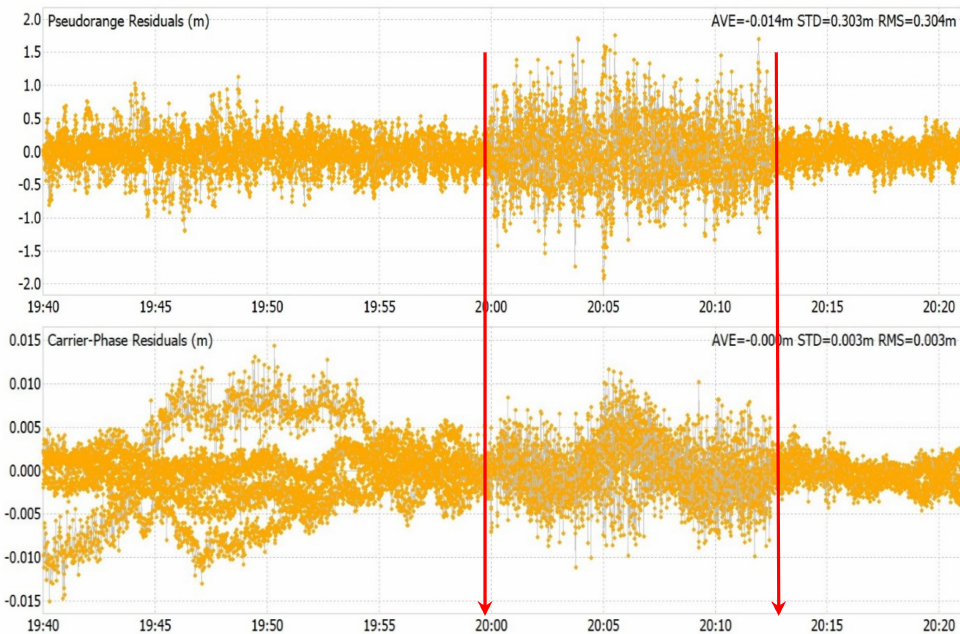
Figure 8. Residuals per satellite in a DGPS (top) and PPK float (bottom) solution for Case 3, baseline 1 (4.1 km) using only L1 data from select satellites (G07, G10, G16, G20, G21, G26, and G27). Red arrows mark the start and end of the jamming incident. Notice the different scales on the y-axis.